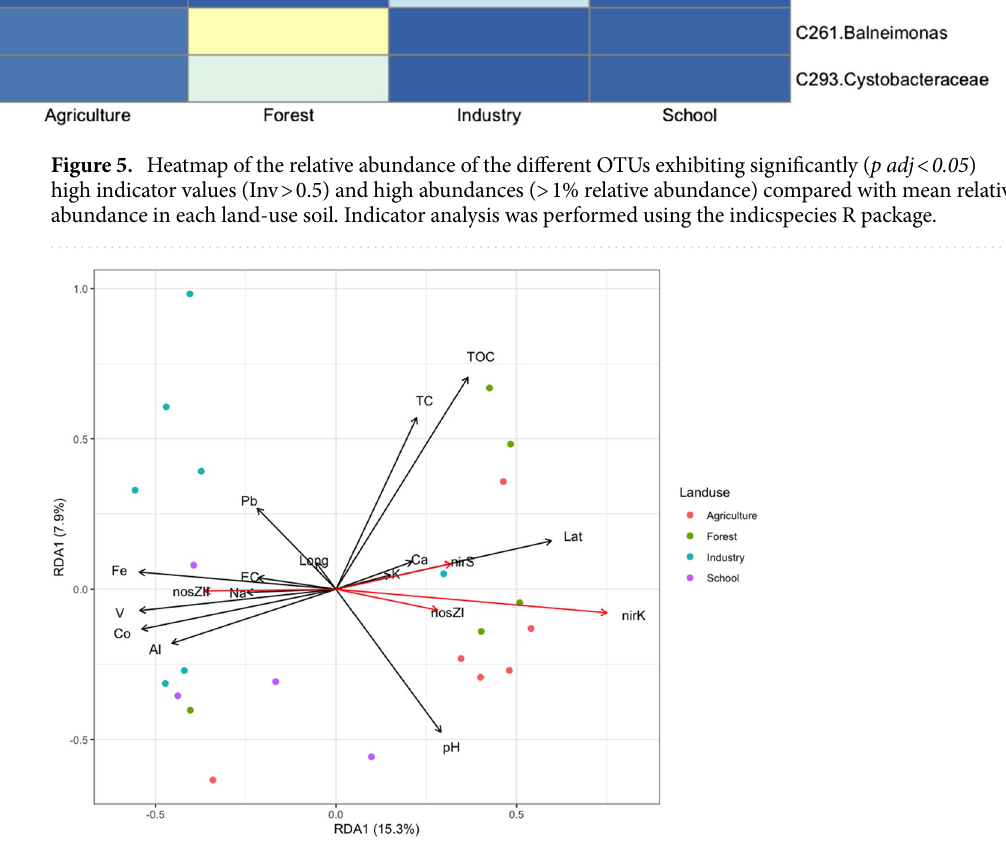
Figure 6. Redundancy analysis (RDA) of soil bacterial communities at genus level. Plots were generated using Euclidean distance matrices with 9999 permutations using Vegan package. Black colored vectors represent environmental variables, which were forward selected ( P adj ≤ 0.05 ). Red colored vectors represent nir K, nir S, nos ZI and nos ZII normalized to 16S rRNA abundance from soils with different land-use